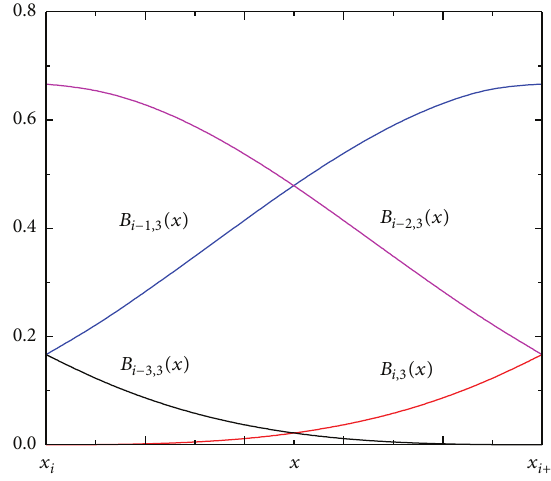
Figure 3: Cubic B-spline curve within the element 𝑖